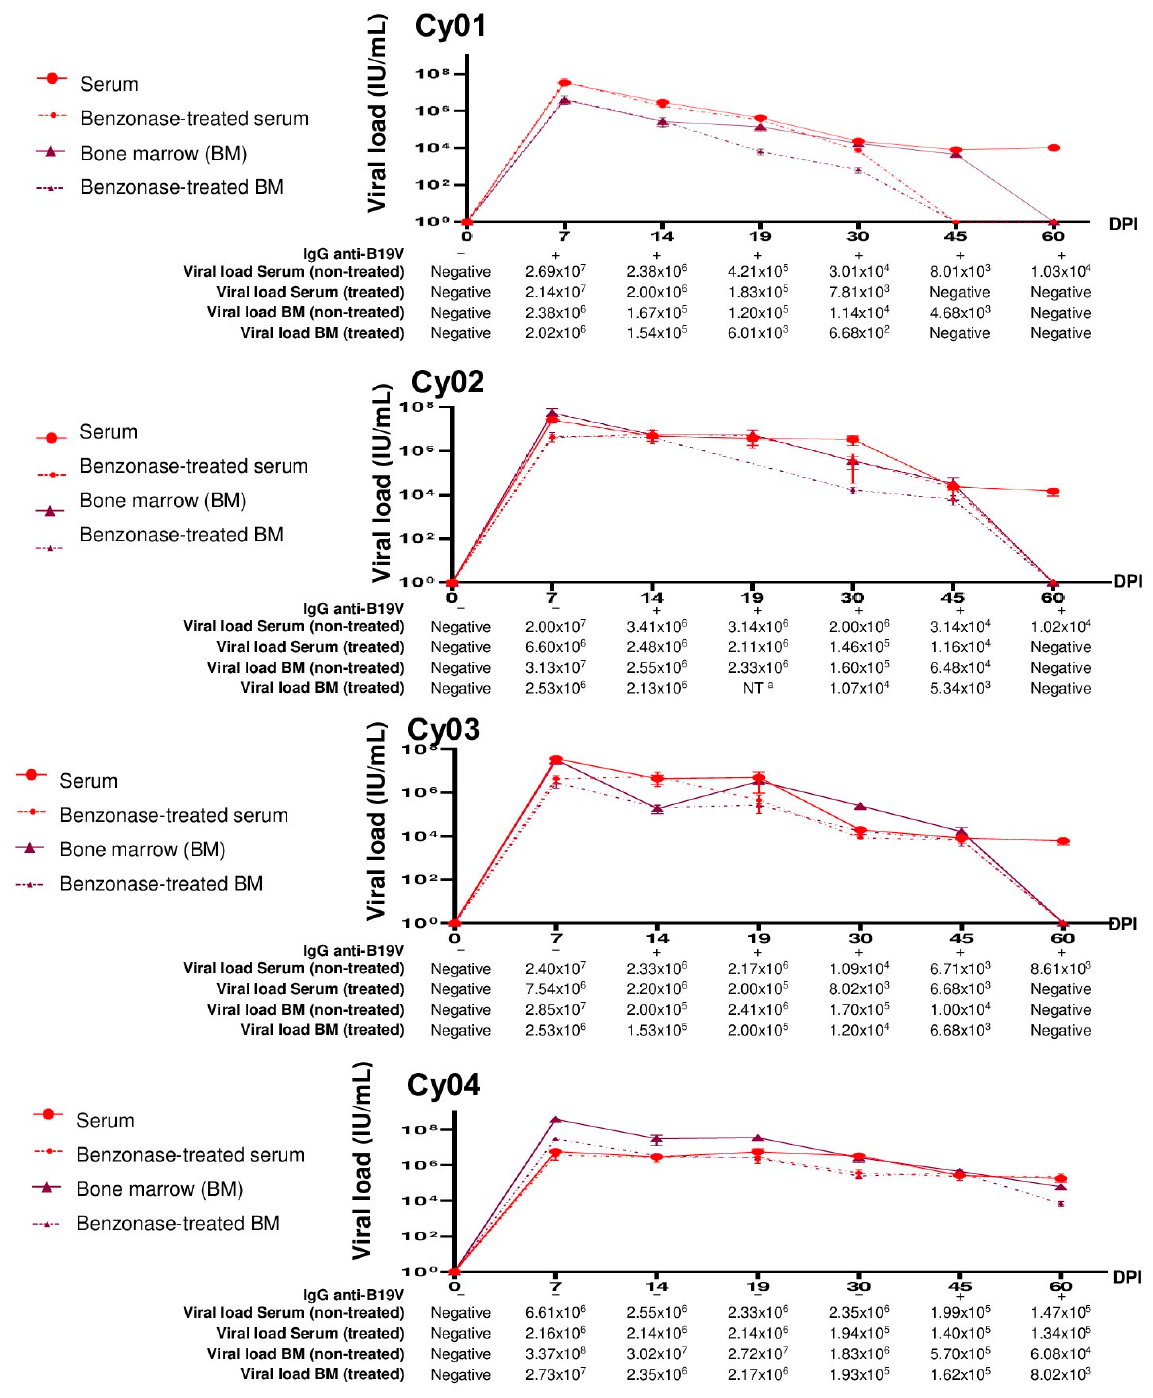
Figure 5. Follow-up of anti-B19V IgG and B19V DNA levels during the experimental infection in cynomolgus monkeys (n = 4). IU/mL: International Units per milliliter; BM: Bone marrow; − : Nega- tive; +: Positive; DPI: Days-post infection; a Not tested due to insufficient bone marrow sample.